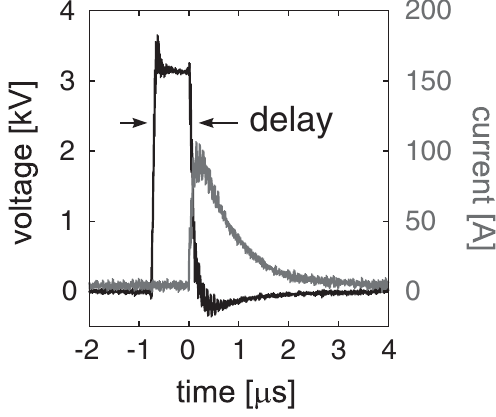
FIG. 8. Example of current and voltage measurements. The voltage is in black, the current in grey. The time delay before the breakdown is deduced from these signals. The time t ¼ 0 corresponds to the breakdown. A slight short overshoot in voltage is observed when the field is applied to the